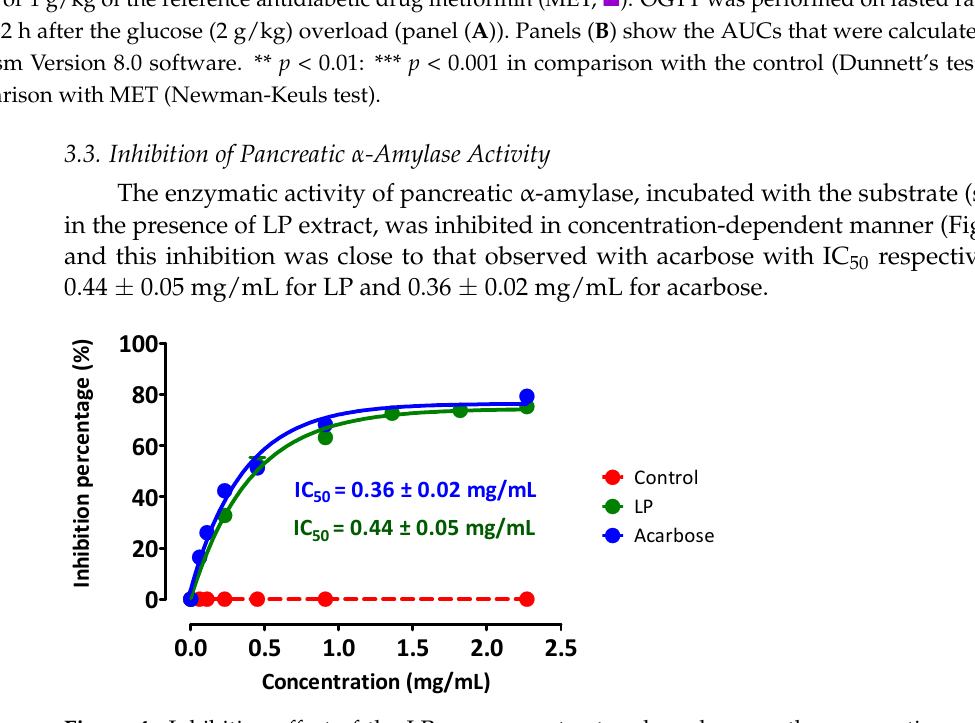
Figure 3. Acute OGTT after oral treatment of rats with combinations of plant extracts. Rats were force-fed intragastrically with distilled water as a negative control (CT, ■ ), 1 g/kg of the different combinations of the plants aqueous extracts (LP + PG, ■ ; LP + FGK, ■ ), or 1 g/kg of the reference antidiabetic drug metformin (MET, ■ ). OGTT was performed on fasted rats every 30 min during 2 h after the glucose (2 g/kg) overload (panel ( A )). Panels ( B ) show the AUCs that were calculated using GraphPad Prism Version 8.0 software. ** p < 0.01: *** p < 0.001 in comparison with the control (Dunnett’s test). ( c ) p < 0.001 in comparison with MET (Newman-Keuls test).